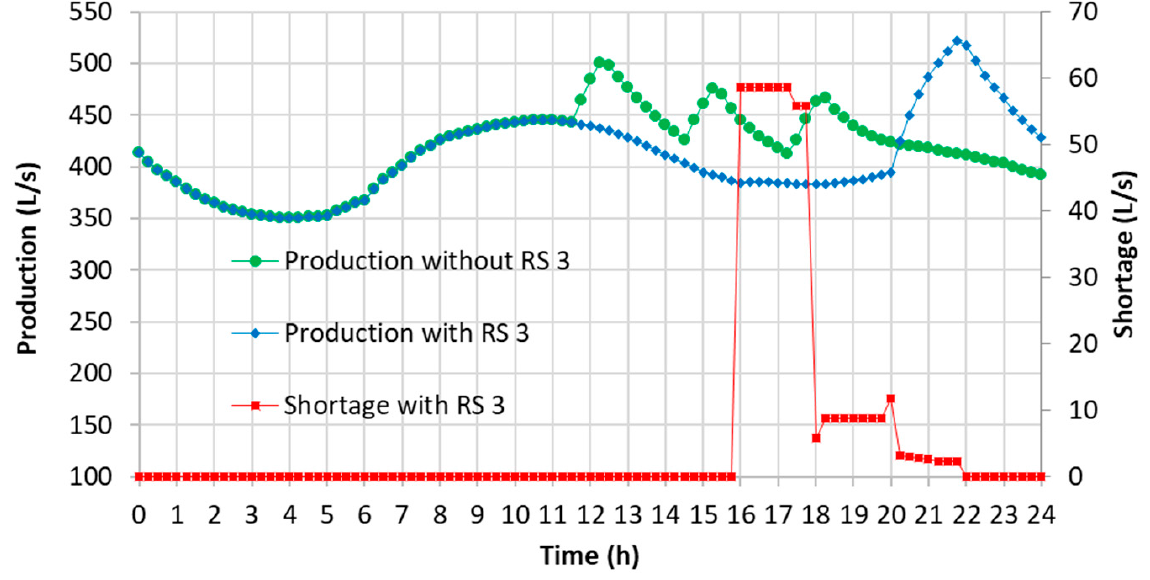
Figure 9. Water production and generated water shortage in the system under RS 3 in comparison with water production in the system under baseline scenario conditions without RS 3.